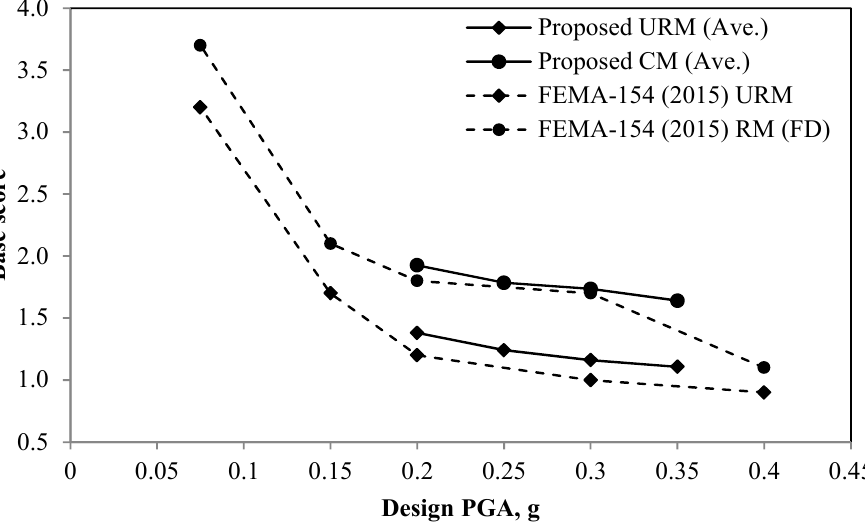
Figure 13. Comparison of the RVS basic scores of different masonry systems in the present study and FEMA P-155 for various seismicity levels.